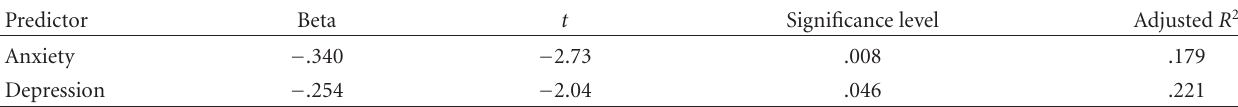
Table 4: Significant variables using stepwise regression analysis to predict goal attainment ∗